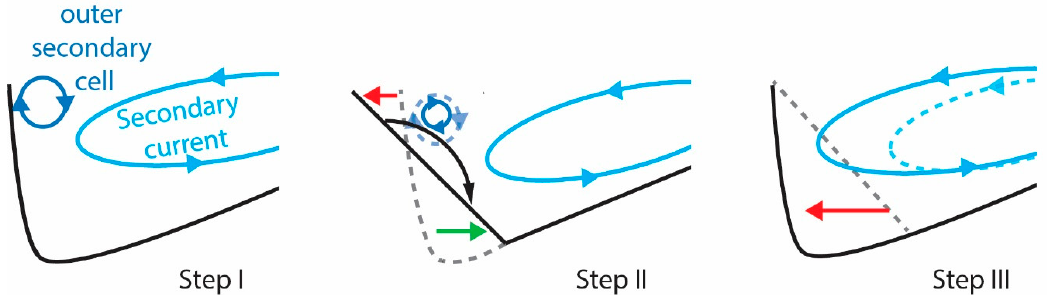
Figure 6. Schematic drawing of the three steps of the erosion process.